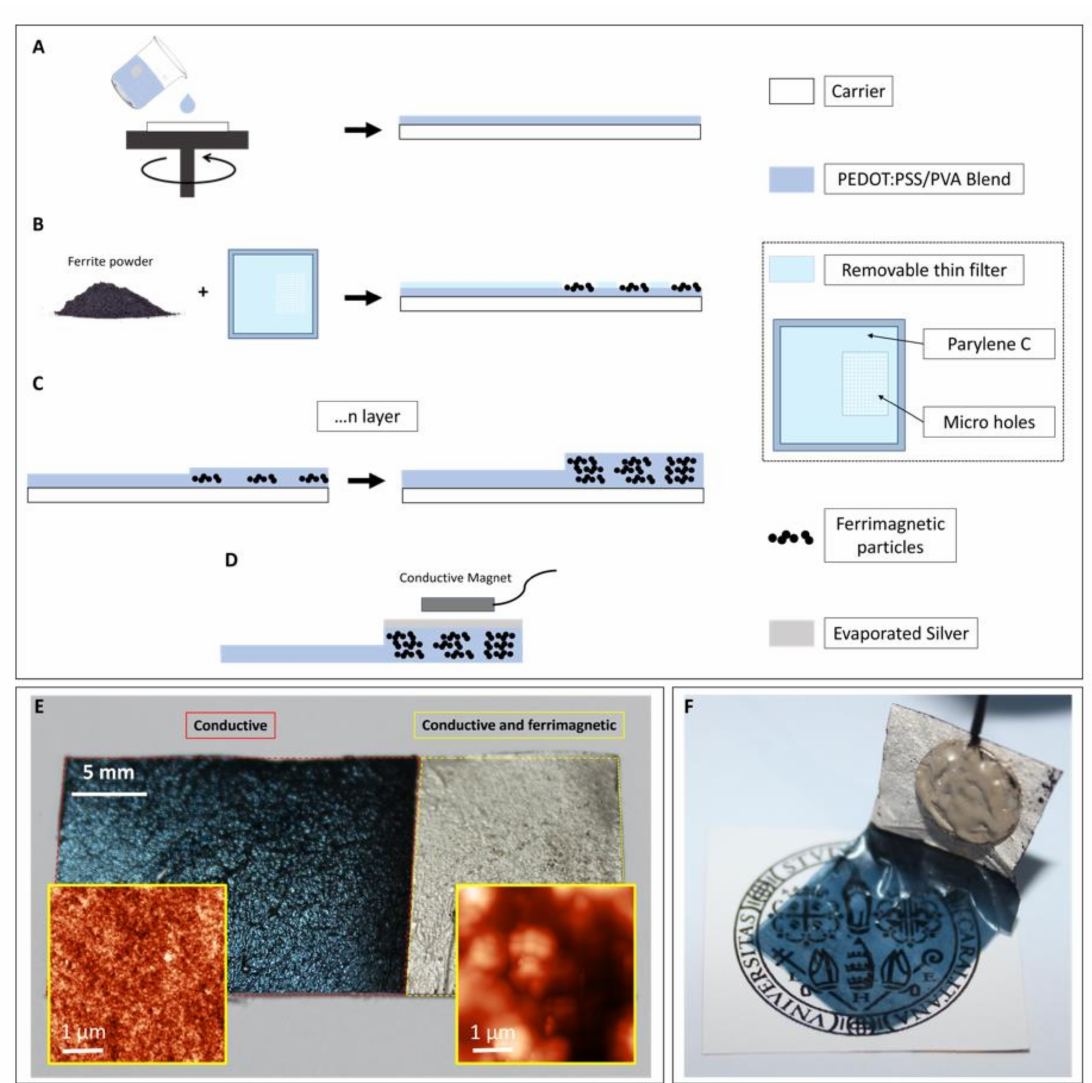
Figure 1. Fabrication process of the ferrimagnetic-conductive film for biopotential recordings. ( A ) A first conductive layer is spin coated onto a PET carrier. ( B ) a first layer of ferrite powder is deposited on the film through a thin Parylene C filter. ( C ) A second conductive layer is spin coated, eventually obtaining a conductive film with a thicker ferrimagnetic-conductive portion. ( D ) A thin Ag layer is evaporated onto the ferrimagnetic-conductive portion of the film in order to improve the magnet–film interface. ( E ) A ferrimagnetic-conductive electrode after the deposition on a piece of standard paper, with the thin, conductive part for an optimal skin/electrode interface and the thicker part, both conductive and ferrimagnetic for the magnetic connection. In the inset: AFM micrographs of both film areas. ( F ) A ferrimagnetic-conductive electrode hanging from a magnet after the peel-off from the PET